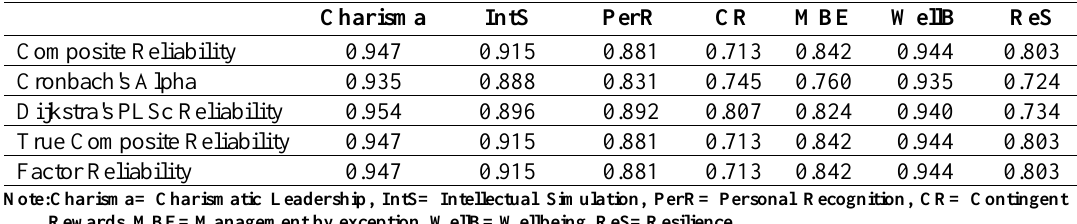
Table.1. Reliability